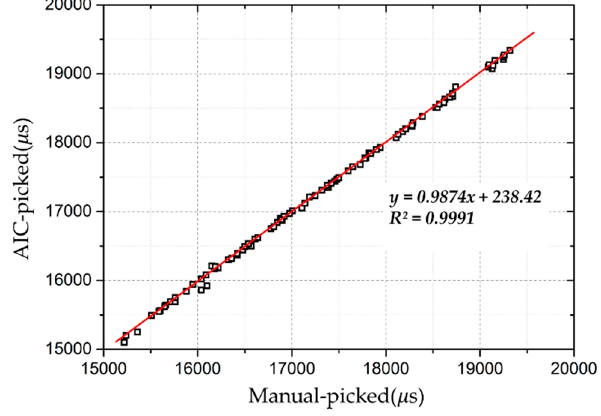
Figure 8. Travel times picked by the AIC have almost the same results as those picked manually.